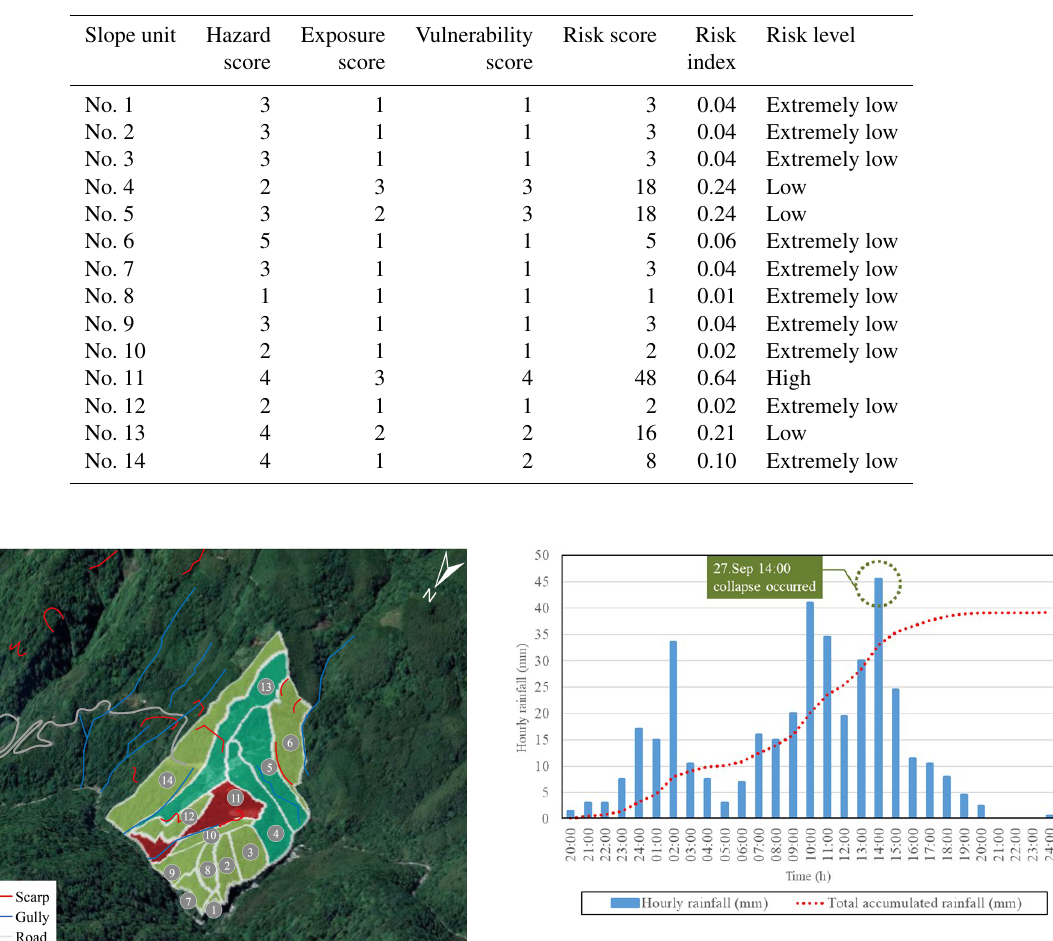
Figure 13. Rainfall records during Typhoon Meiji (26 September to 27 September